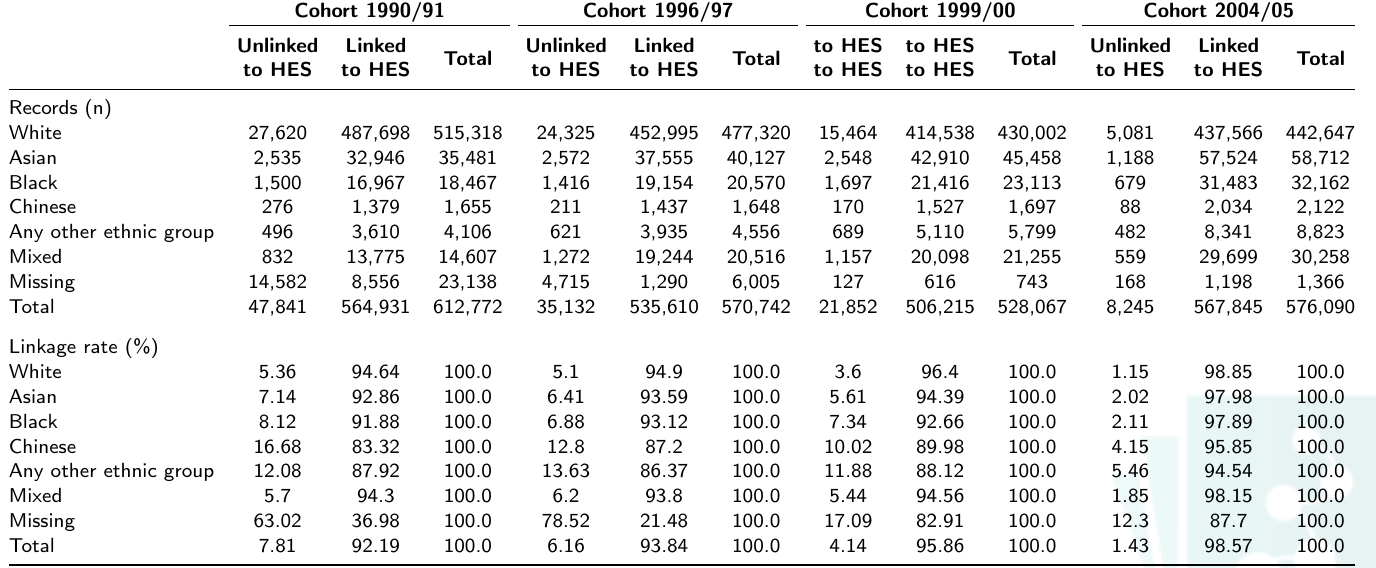
Supplementary Table 8.2: Linking rate by ethnic group and